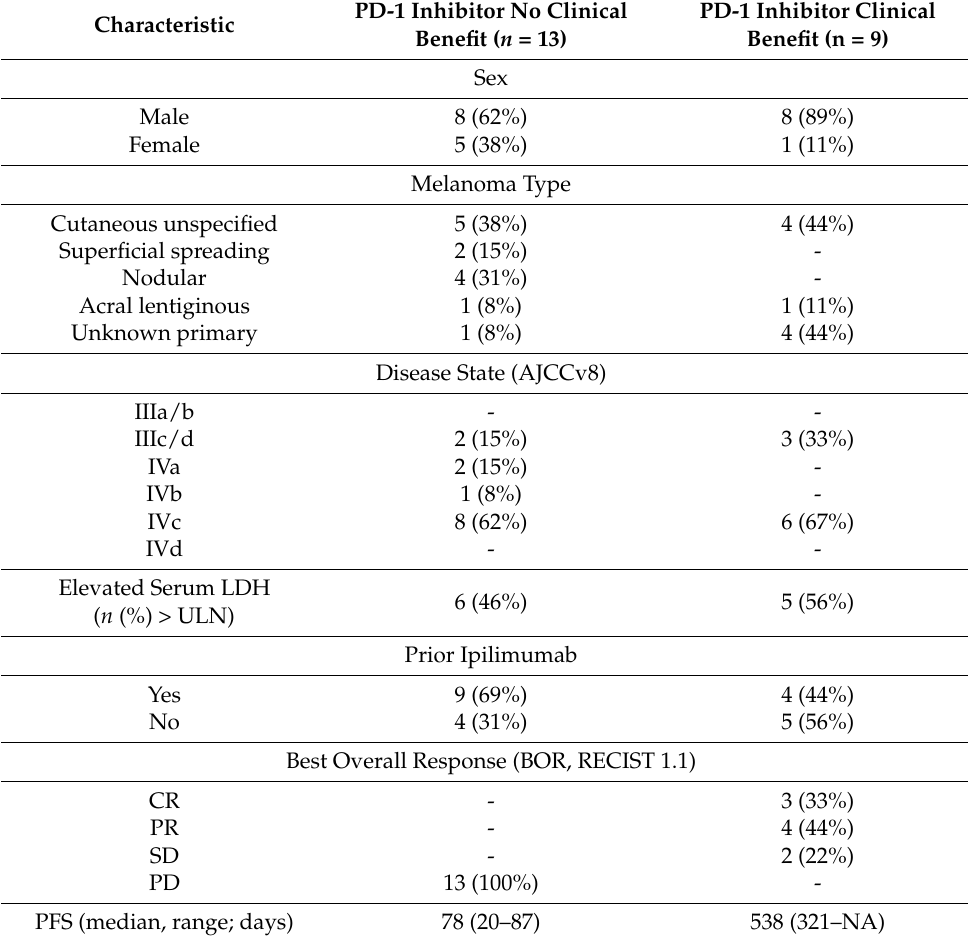
Table 1. Clinical characteristics of the PD-1 inhibitor treated patient